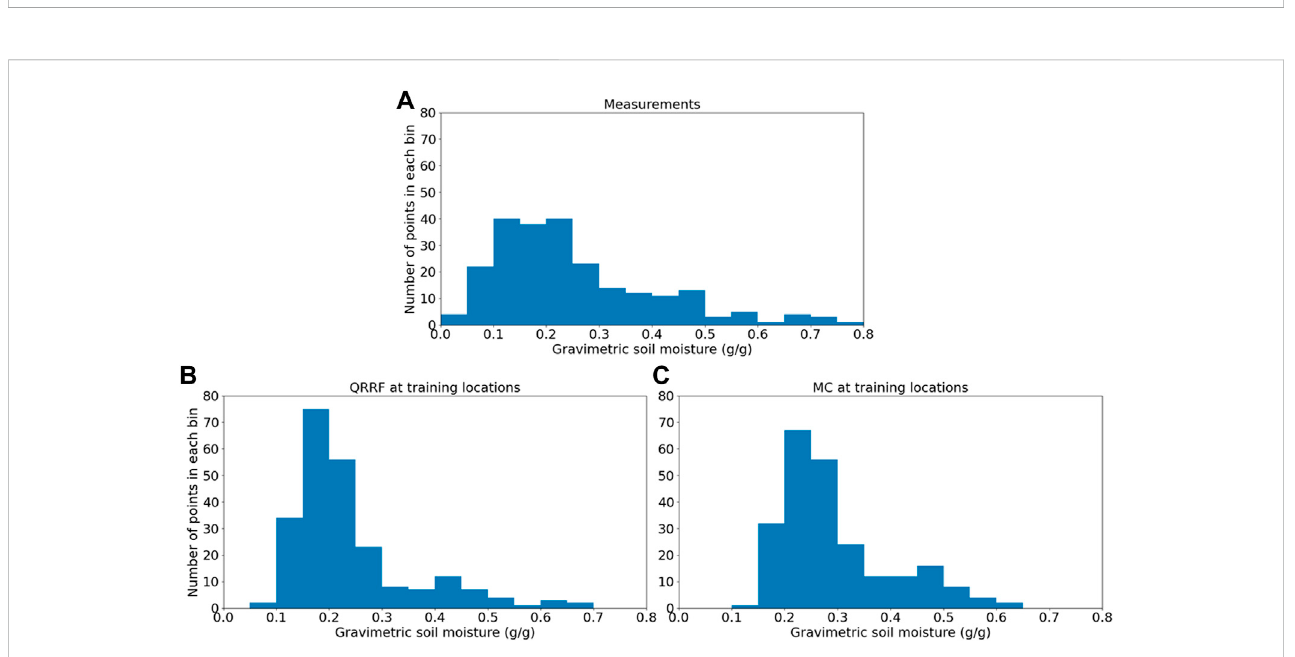
FIGURE 11 Histograms displaying the distribution of the measured soil moisture values (A) , soil moisture values at the same locations predicted from QRRF (B) , and mean predictions from the MC approach (C) .